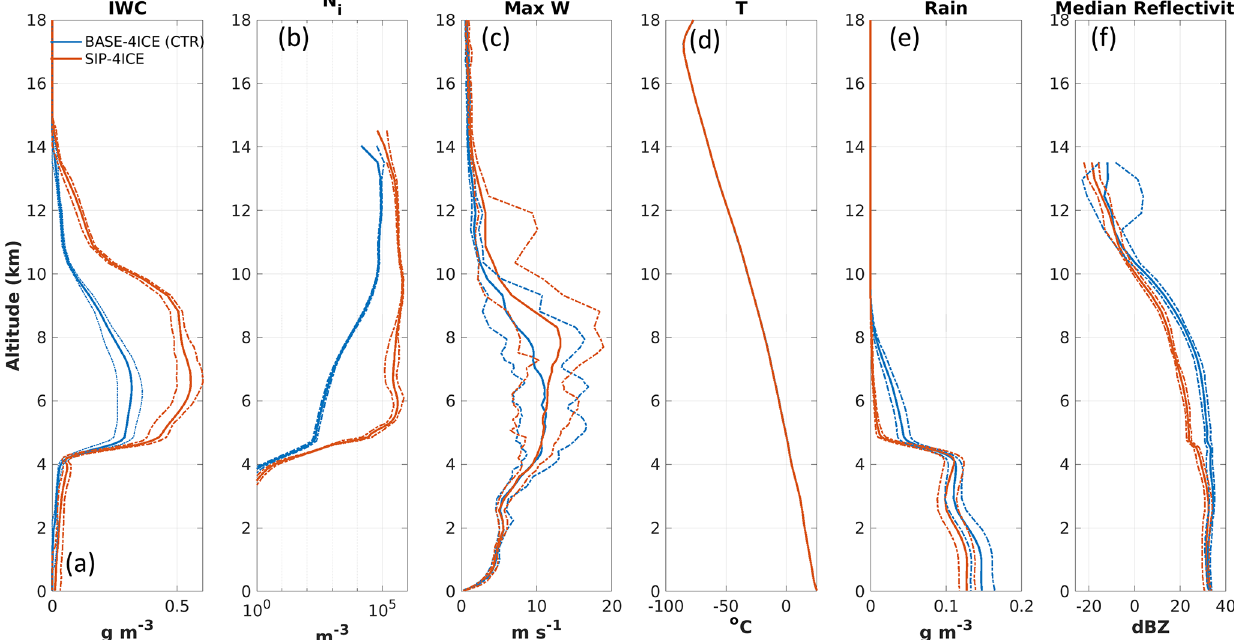
Figure 7. Same as Fig. 4 but showing the domain-averaged profiles for the CTR and SIP simulations with four ice categories, for 11 ensemble members each. The dot-dash lines show the minimum and maximum values among the ensemble members. The results are calculated based on data at 120min after the model initiation.